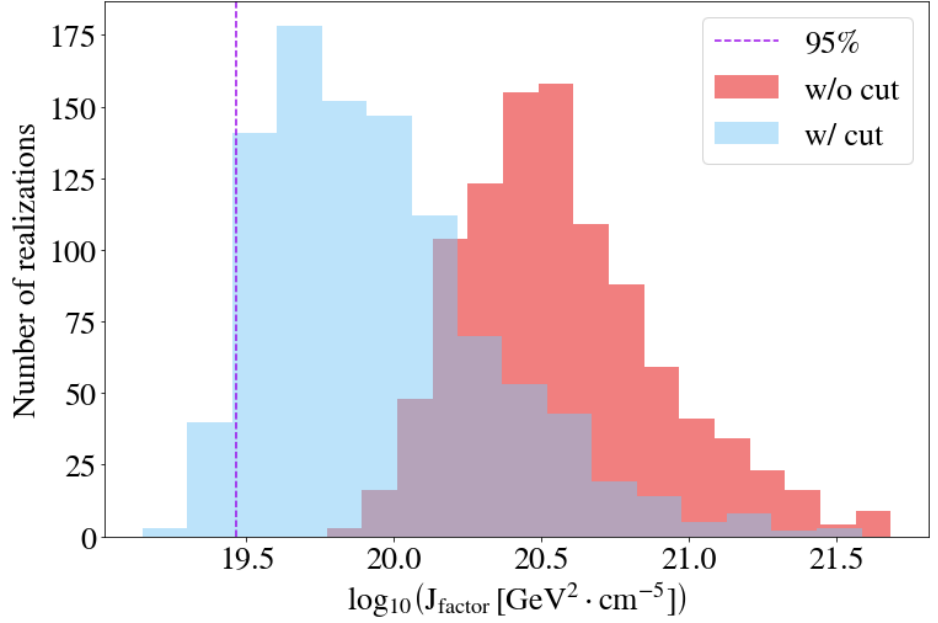
Figure 3. J-factor distributions for the brightest subhalo across 1000 realizations of the DM subhalo population as derived in [23] from the Via Lactea II N-body simulation. Red and blue histograms show, respectively, the values before and after applying our selection cuts on the simulated DM subhalos, namely a mass cut ( M ≤ 10 7 M (cid:12) ) and a coordinate cut ( | b | > 30 ◦ ). The dashed, purple vertical line marks the value of the J-factor that will be used to set the 95% C.L. DM limits in Section 3, and it is defined as the one above which 95% of the J-factor distribution is